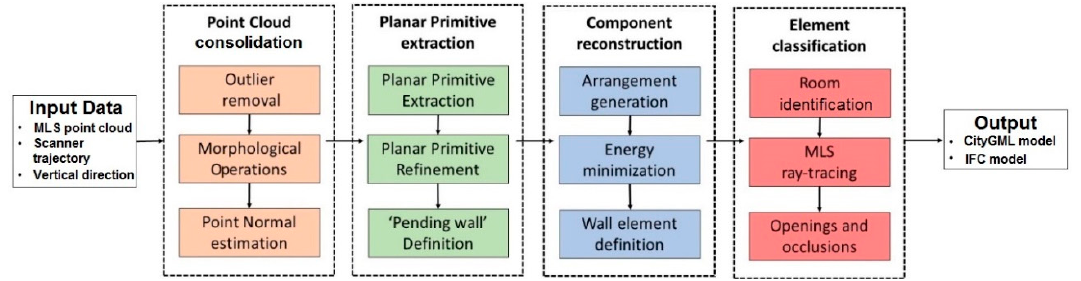
Figure 1. Workflow of the developed methods for automatic indoor modeling (AIR) of building rooms. MLS = mobile laser scanner